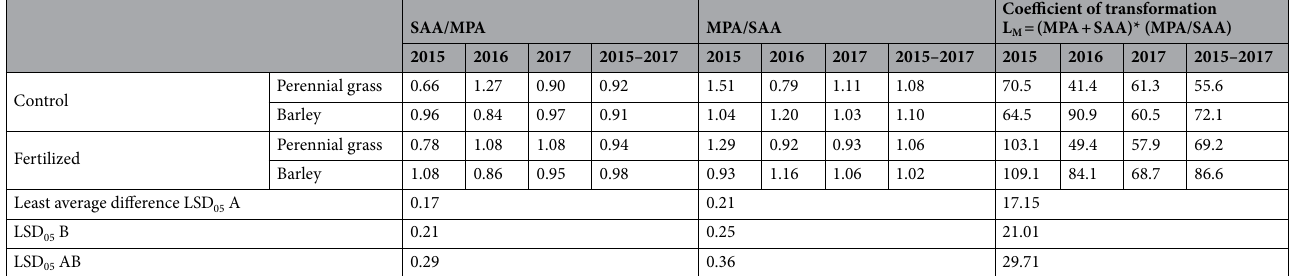
Table 3. Direction of soil-microbiological processes of irrigated meadow-chernozem soil depending on fertilization.